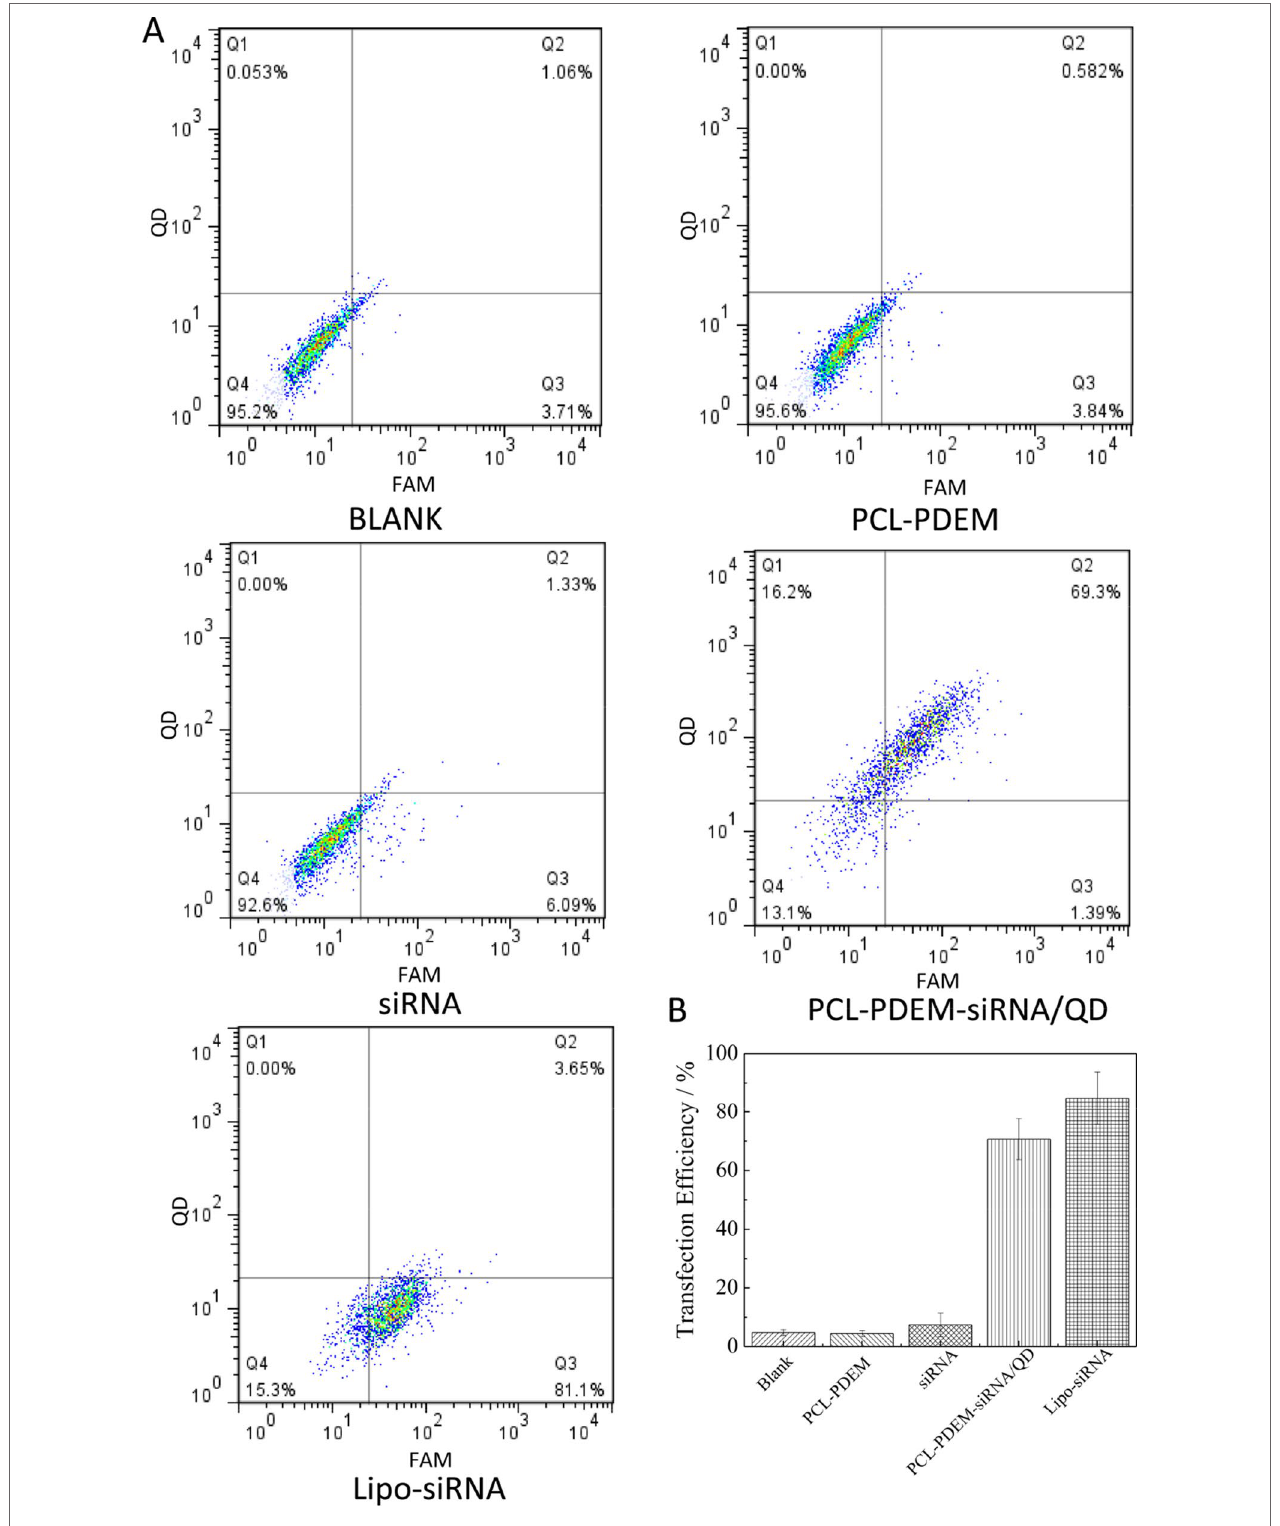
FIGURE 8 | Transfection efficiency of SK-Hep1 cells different nanoformulations determined by flow cytometry analysis. (A) Representative pictures, where cells were treated with (I) blank, (II) PCL-PDEM, (III) free siRNA, (IV) PCL-PDEM-siRNA/QDs, and (V) Lipo-siRNA. (B) Percentage of cells transfected after 4-h treatment, evaluated from experiments shown in (A) . Values are mean ± SD, n =